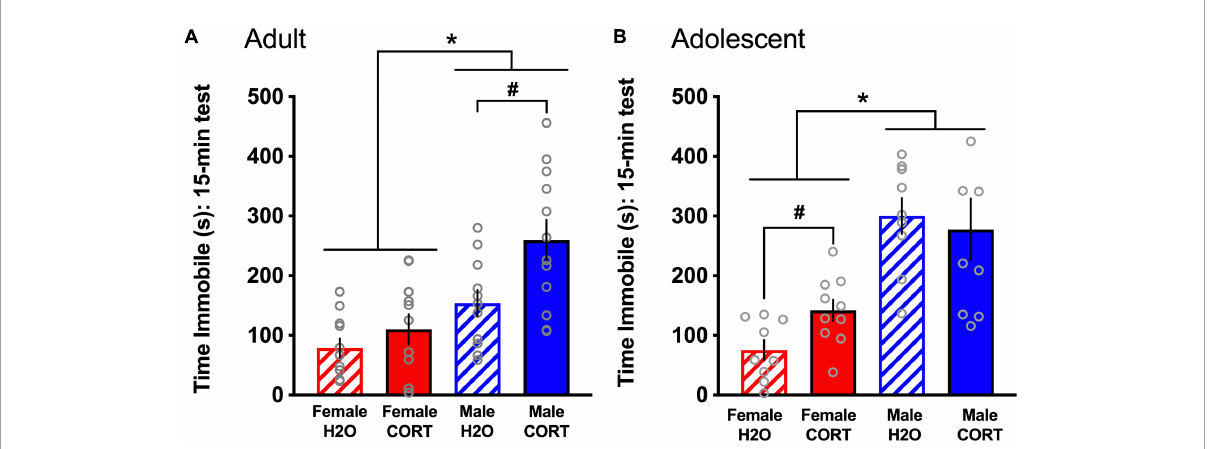
FIGURE5 CORT exposure alters depressive-like behavior in a sex- and age-dependent manner. Adult-exposed (A) females spent significantly less time immobile than males, and CORT treatment increased immobility in males only. Adolescent-exposed (B) females also spent significantly less time immobile than males, but CORT treatment increased immobility in females only. * p < 0.001 (male vs. female); # p < 0.01 (H 2 O vs. CORT).